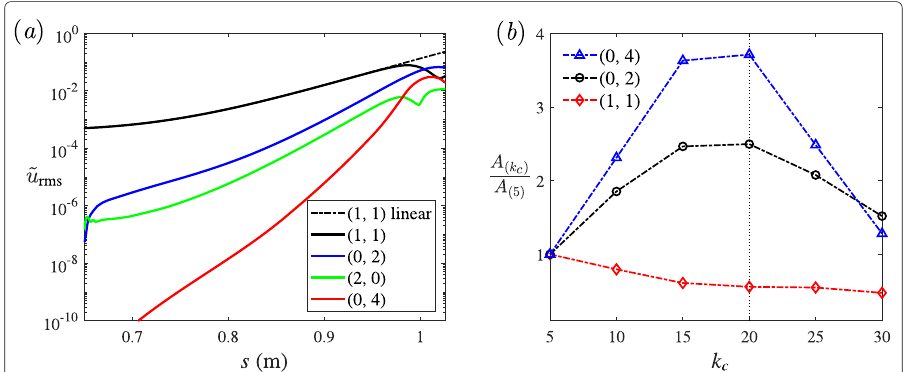
Fig. 6 Streamwise development of representative waves in the oblique-mode breakdown with f = 500kHz : ( a ) wave amplitudes with k c = 10 and ( b ) amplitude ratios at s = 1.02m with k c